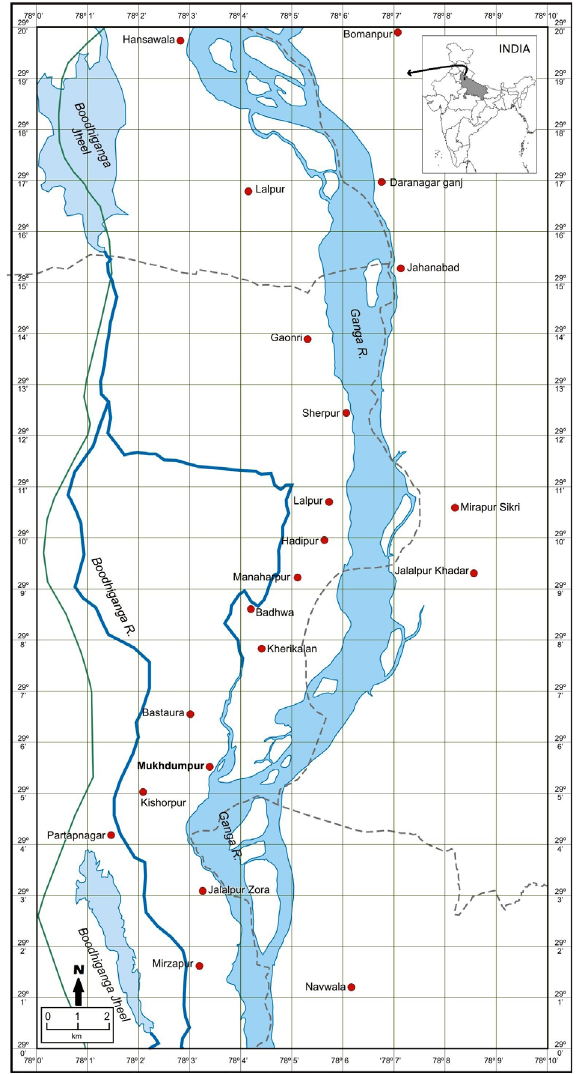
Figure 1. Location map of villages inside the HWS, Uttar Pradesh India (not to